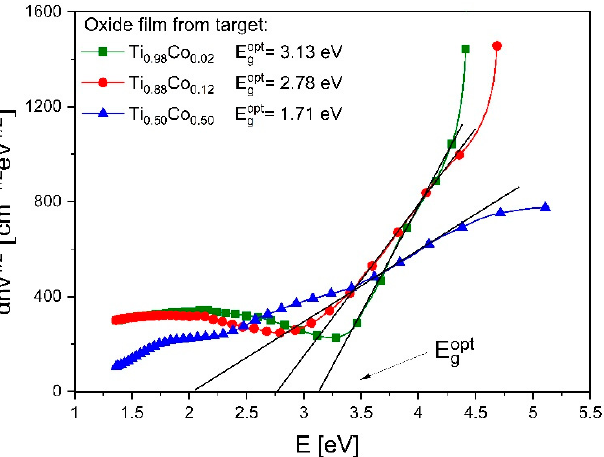
Figure 11. Tauc plots for (Ti,Co)Ox thin films prepared from different targets. Designations: E gopt — optical band gap.